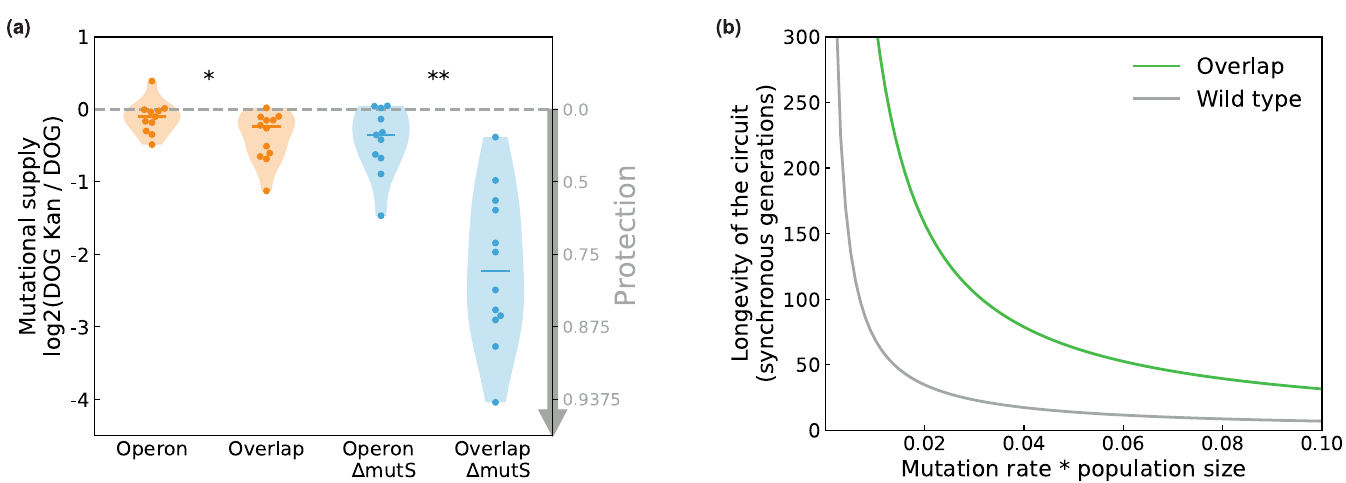
Fig 5. Experimentally measured protection from mutations and expected resulting increase in circuit lifetime. (a) The overlap protects galK from loss-of-function mutations. We measure the fraction of galK loss-of-functions (permitting growth on DOG) that did not affect kanR. The lower this fraction, the higher the protection. Each point represents an independent population. The violin plots show the median and kernel density estimation for 12 independent populations. (b) Theoretical median lifetime of the circuit, with the measured protection for the Δ mutS strain, depending on the rate of loss-of-function mutations and on population size. The lifetime is expressed as the number of generations before the first beneficial loss-of-function mutation